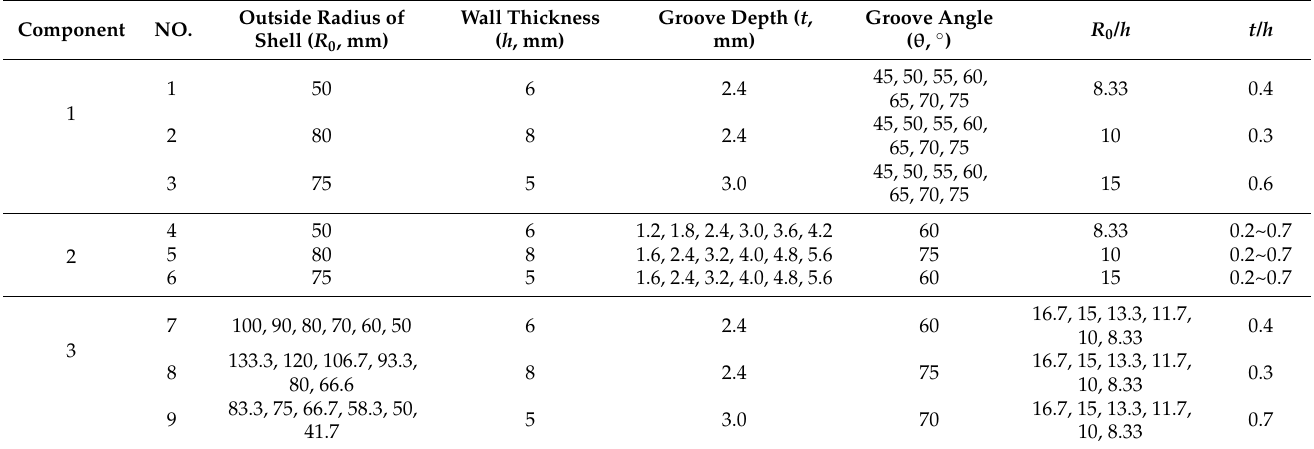
Table 1. Geometric parameters of the grooved shell used to determine